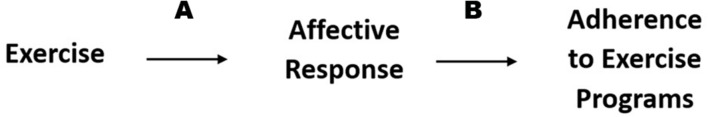
The exercise–affect–adherence pathway. Path (A) refers to the domain-specific influence of exercise behavior on affective response. Path (B) refers to the domain-general influence of affective response on future exercise behavior.